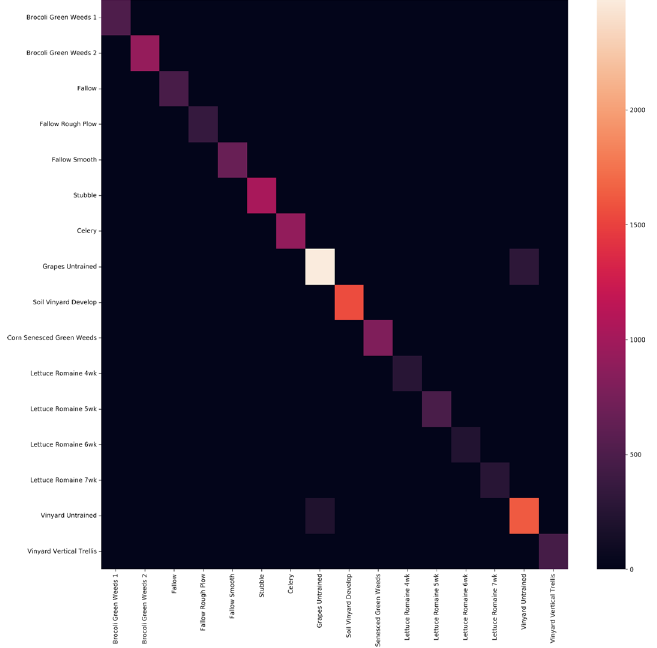
Fig. 10 Salinas Confusion Matrix for PCA 30 CEU-Net no patching with a 75%/25% Training/Testing split